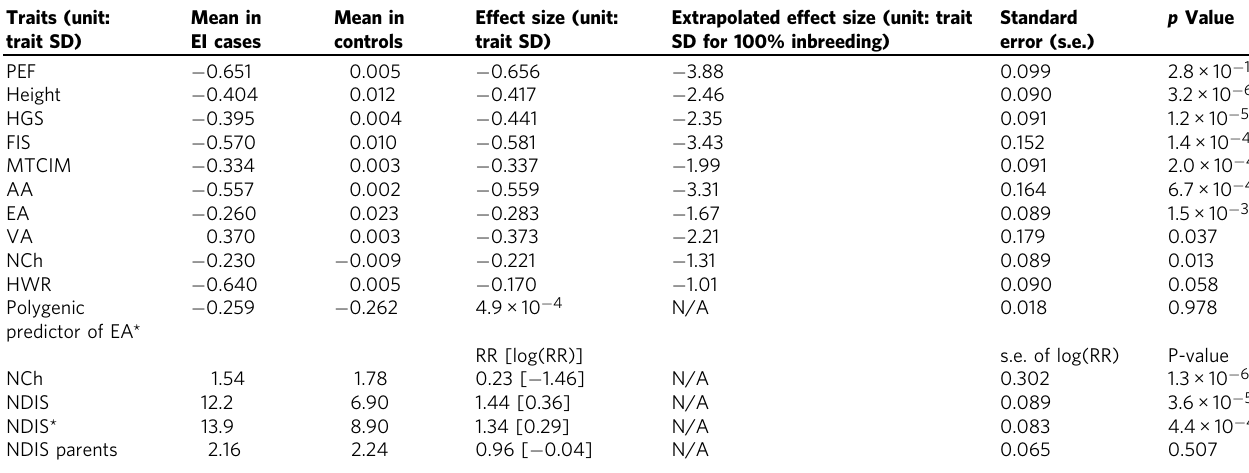
Table 3 Association between extreme inbreeding (EI) and multiple traits measured in UK Biobank participants (125 EI cases vs. 345,276 EI controls) Traits (unit: Mean in Mean in Effect size (unit: Extrapolated effect size (unit: trait trait SD) EI cases controls trait SD) SD for 100% inbreeding)